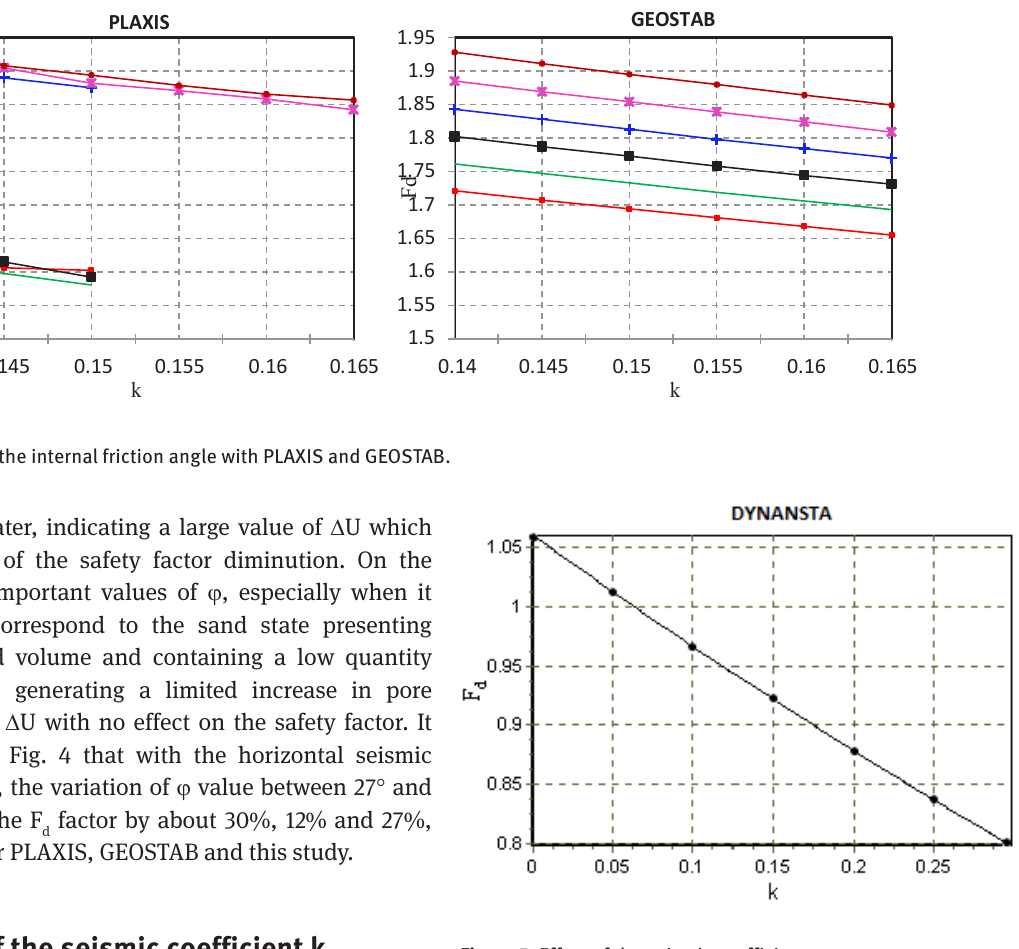
Figure 5: Effect of the seismic